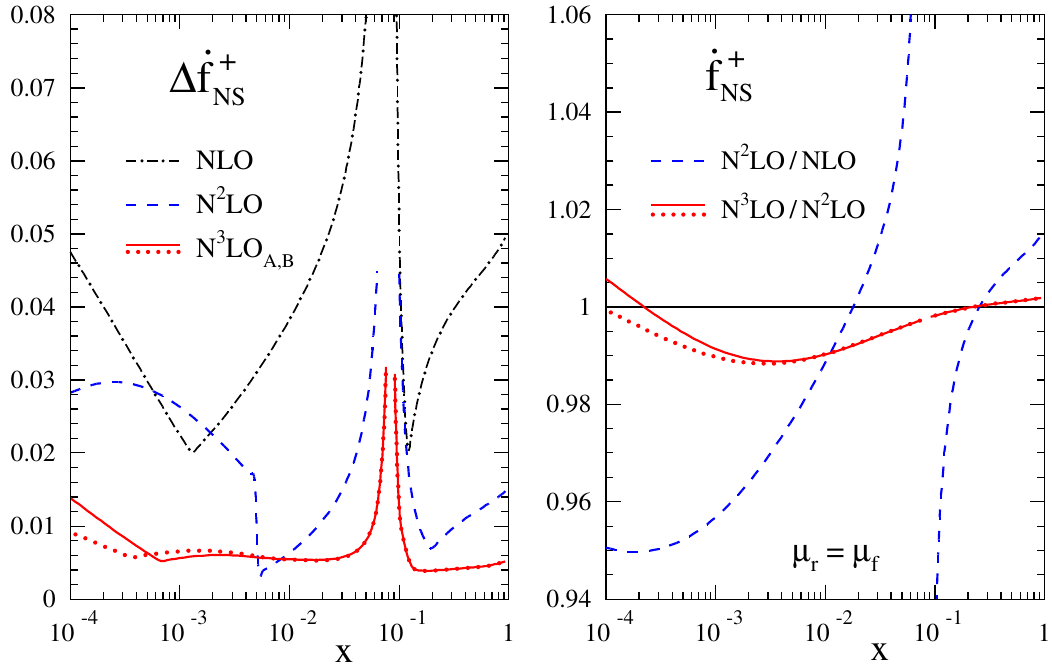
Figure 14 . As (cid:12)gure 10, but for its time-like counterpart, the fragmentation function f + same input (5.6) and (5.7) is used here, so all di(cid:11)erences to (cid:12)gure 10 are due to the di(cid:11)erent N n> 0 LO splitting